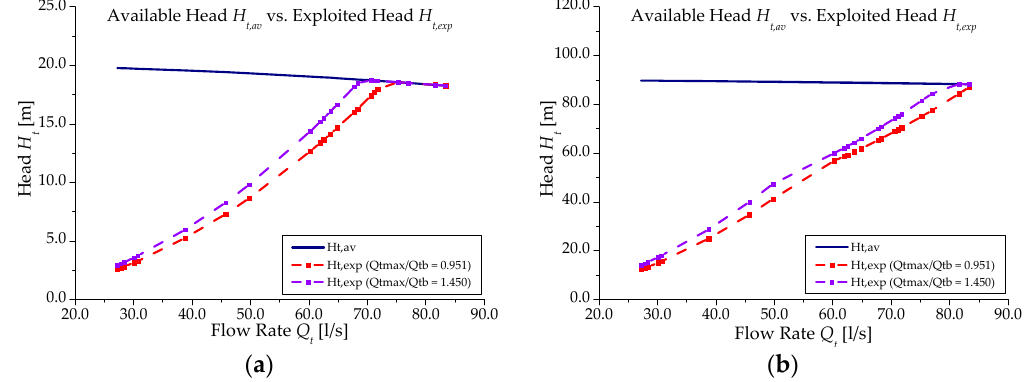
Figure 4. Comparison between available head H t,av and exploited one H t,exp for: ( a ) Scenario 1; ( b ) Scenario